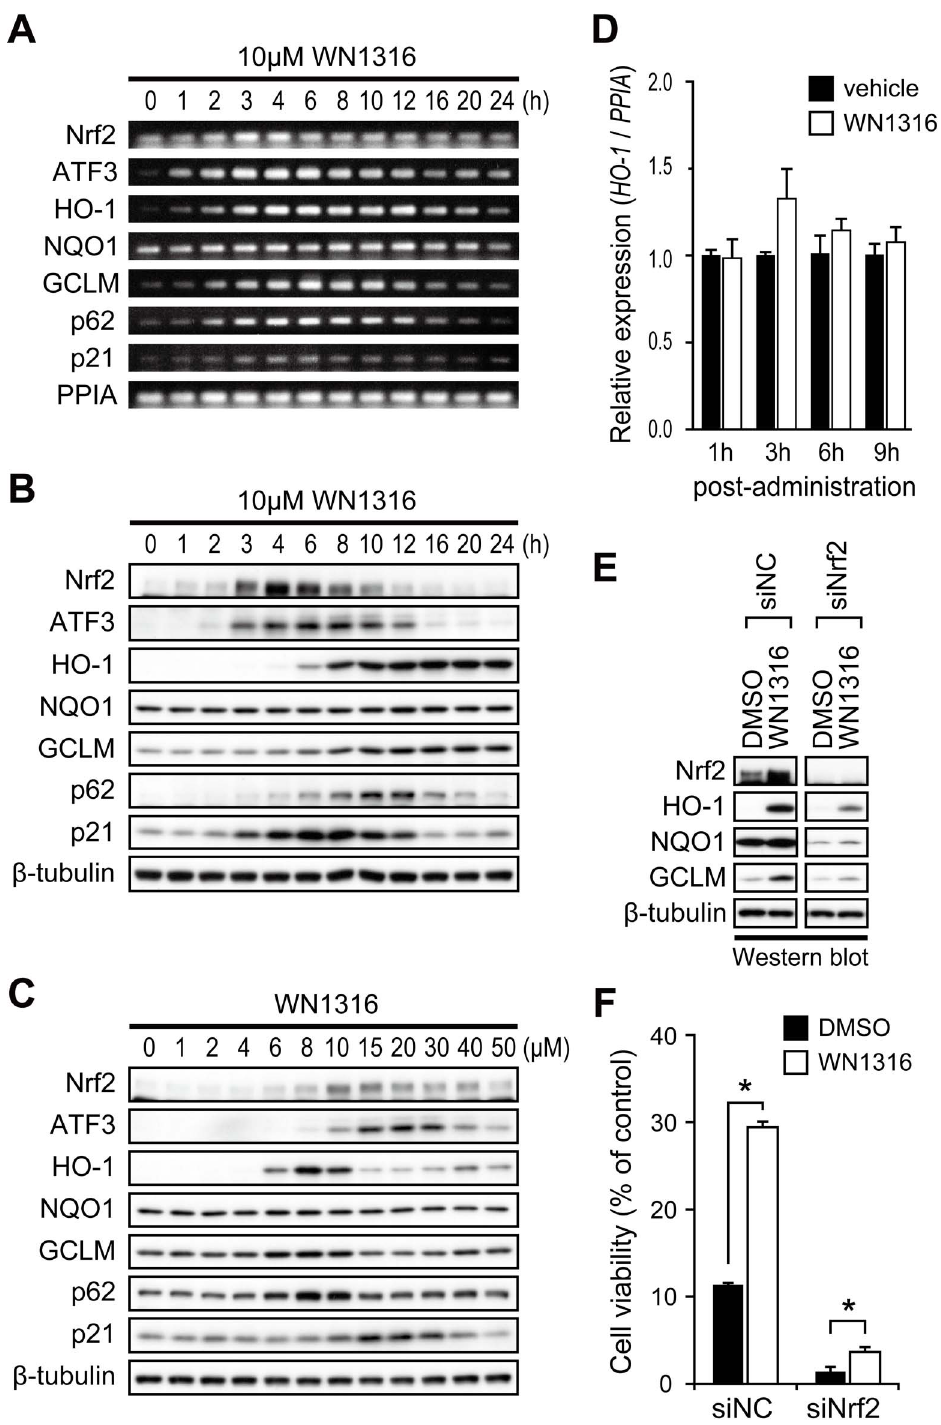
Figure 2. Nrf2 is essential for antioxidant and detoxifying enzyme gene induction by WN1316. (A–B) Effect of the expression of mRNAs and proteins, including Nrf2, ATF3, HO-1, NQO1, GCLM, p62 and p21, in WN1316-treated cells. Differentiated SH-SY5Y cells were treated with 10 m M WN1316 or DMSO for the indicated times. Total RNA and cell extracts from WN1316-treated SH-SY5Y cells were used for RT-PCR (A) and Western blot analysis (B), respectively. Peptidylprolyl isomerase A (PPIA) was used as a control for RT-PCR. b -tubulin was used as a loading control for protein. (C) Western blot analysis of proteins shown in A in a WN1316 dose-dependent manner. SH-SY5Y cells were incubated with 1 to 50 m M WN1316 for 8 h. Equal amount of protein from cell lysates were analyzed by using antibodies as indicated. b -tubulin was used as a loading control for protein. (D) Quantitative RT-PCR analysis of HO-1 mRNA from the lumbar spinal cord of wild type mice administered with WN1316 (100 m g/kg) (n=3) or vehicle (physiological saline) (n=3). Relative mRNA expression was acquired by normalizing HO-1 mRNA to PPIA mRNA. Data are expressed as mean 6 SEM. (E–F) SH-SY5Y cells were transfected with 5 nM nonsilencing siRNA (siNC), or Nrf2 siRNA (siNrf2). At 48 h after transfection, cells were treated with 6 m M WN1316 for 8 h. The expression of Nrf2, HO-1, NQO1, and GCLM was analyzed by Western blotting (E). The cell viability after the exposure to